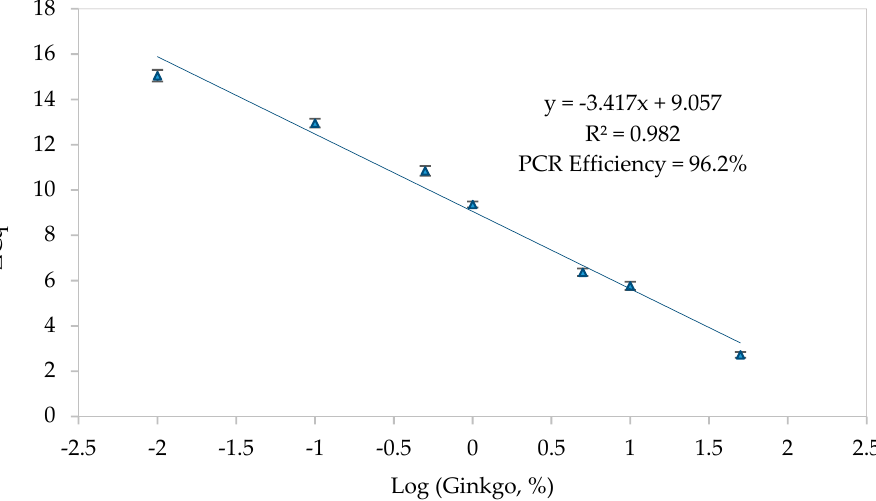
Figure 2. Normalized calibration curves obtained by real-time PCR, targeting the ITS1 region of ginkgo, using the binary mixtures of G. biloba in C. sinensis (50%, 10%, 5%, 1%, 0.5%, 0.1%, 0.05% and 0.01% ( w / w )). The normalized ∆ Cq method was performed by the parallel amplification of a eukaryotic sequence (18S rRNA) as reference (mean values of six independent assays with n = 3 replicates).